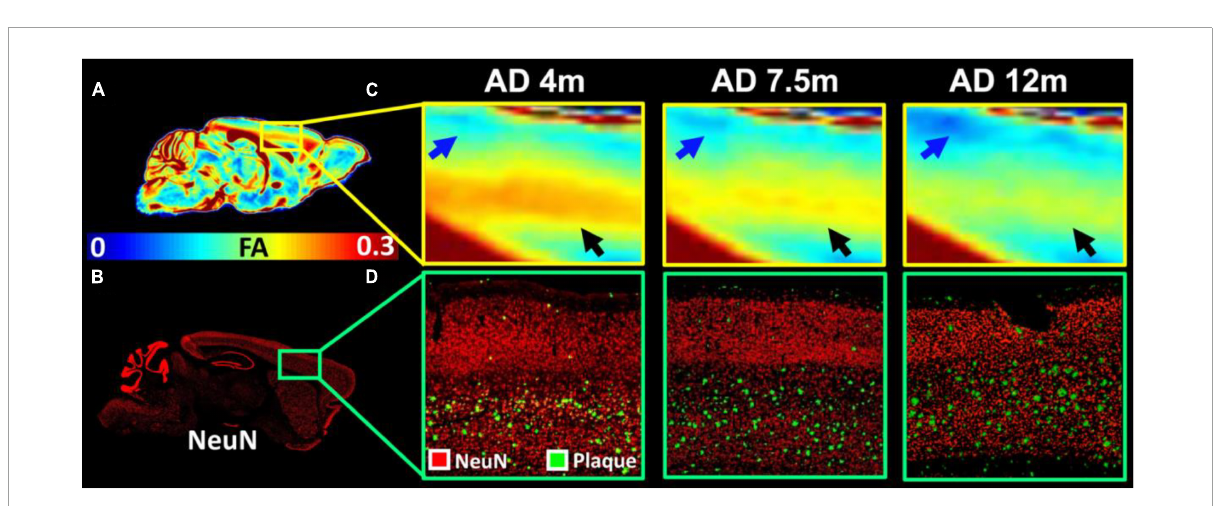
FIGURE5 The age-dependent FA (A,C) and beta-amyloid staining images of 5xFAD mice (B,D) . The FA was gradually decreased with age in both upper layers (blue arrows in C ) and lower layers (black arrows in C ) of the cortex. The beta-amyloid staining was overlayed on the NeuN staining (D)